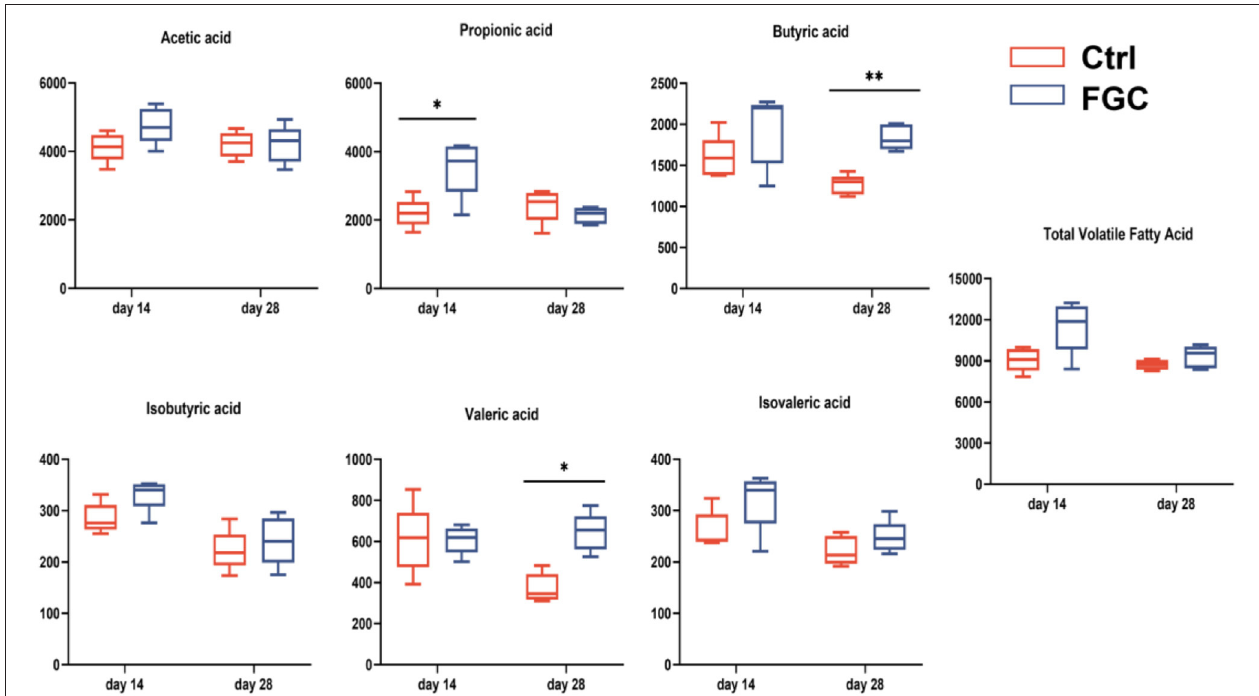
FIGURE 11 | Fecal volatile fatty acid of piglets as affected by dietary FGC supplementation (mg/g). Ctrl, corn-soybean basal diet; FGC, corn-soybean basal diet with 2,000 mg/kg ferrous glycine chelate. Data were shown as means ± SEM. ** p < 0.01; * p < 0.05. N =